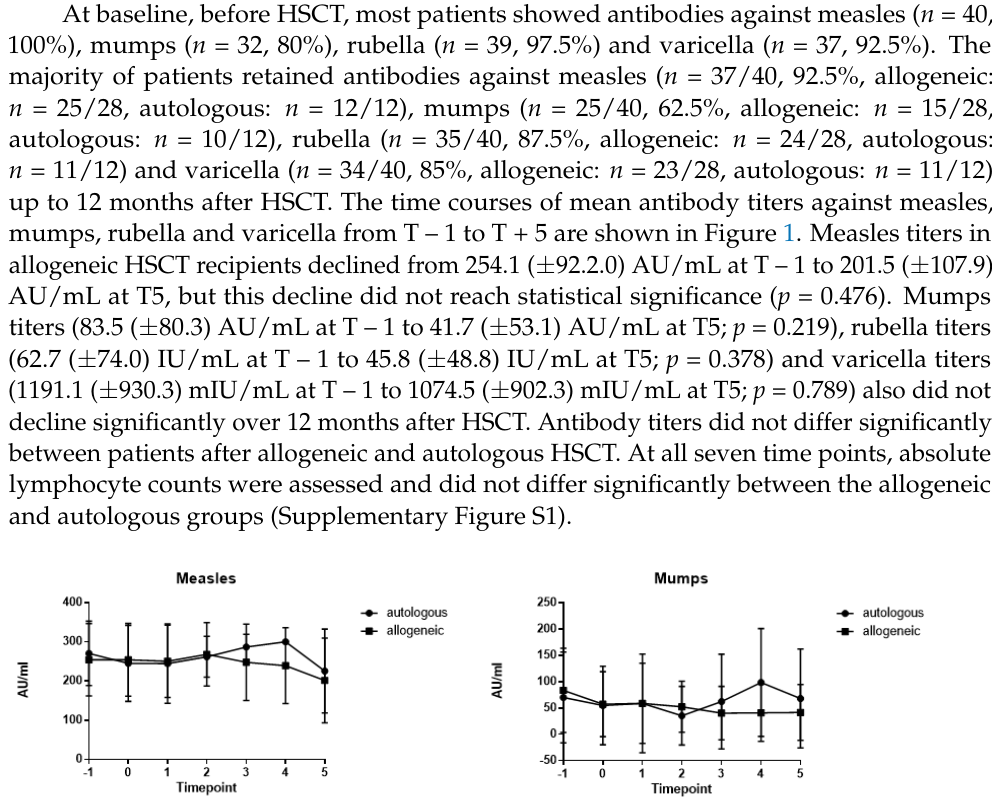
significantly different compared to allogeneic HSCT patients without aGvHD (266.9 ± 77.1 AU/mL; p = 0.447; Figure 2). Antibody titers against mumps (67.7 ± 55.1 AU/mL with aGvHD vs. 35.3 ± 39.5 AU/mL without aGvHD; p = 0.091), rubella (37.6 ± 38.8 IU/l with aGvHD vs. 46.1 ± 22.8 IU/l without aGvHD; p = 0.453) and varicella (1057.0 ± 959.8 mIU/mL with aGvHD vs. 867.4 ± 605.2 mIU/mL without aGvHD; p = 0.398) were not significantly different when comparing patients with and without aGvHD. Antibody titers of patients with aGvHD were not significantly different compared to patients after autologous HSCT. In addition, the antibody titers at baseline ( T − 1 ) were compared to the time point with the highest severity of acute GvHD (T2 or 3) in patients with GvHD. There was no signif- i cant difference between the antibody titers at baseline or at the highest severity of acute GvHD (Supplementary Figure S2).